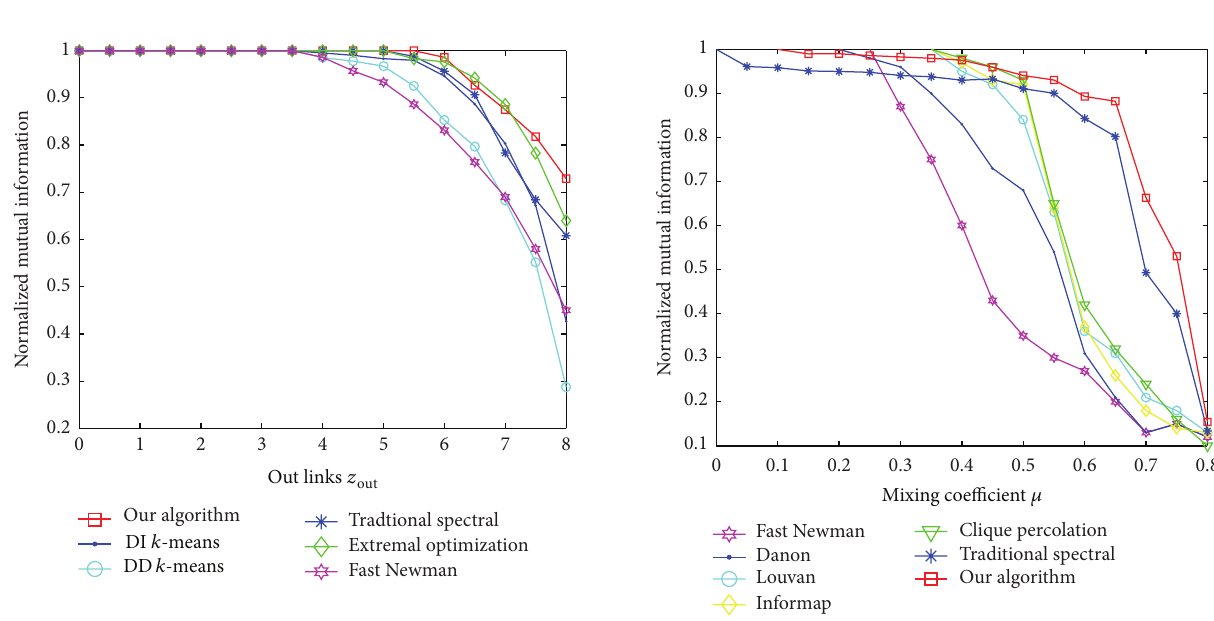
algorithm, Louvain algorithm, Infomap algorithm, Clique